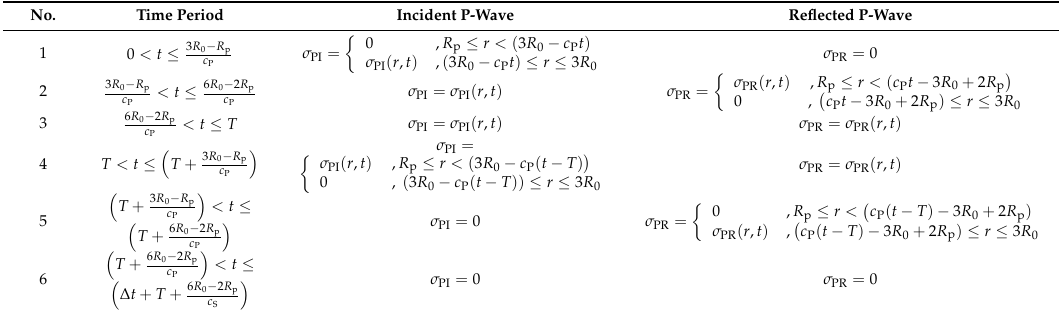
Table 1. P-wave functions according to the division of time periods in Figure 3.